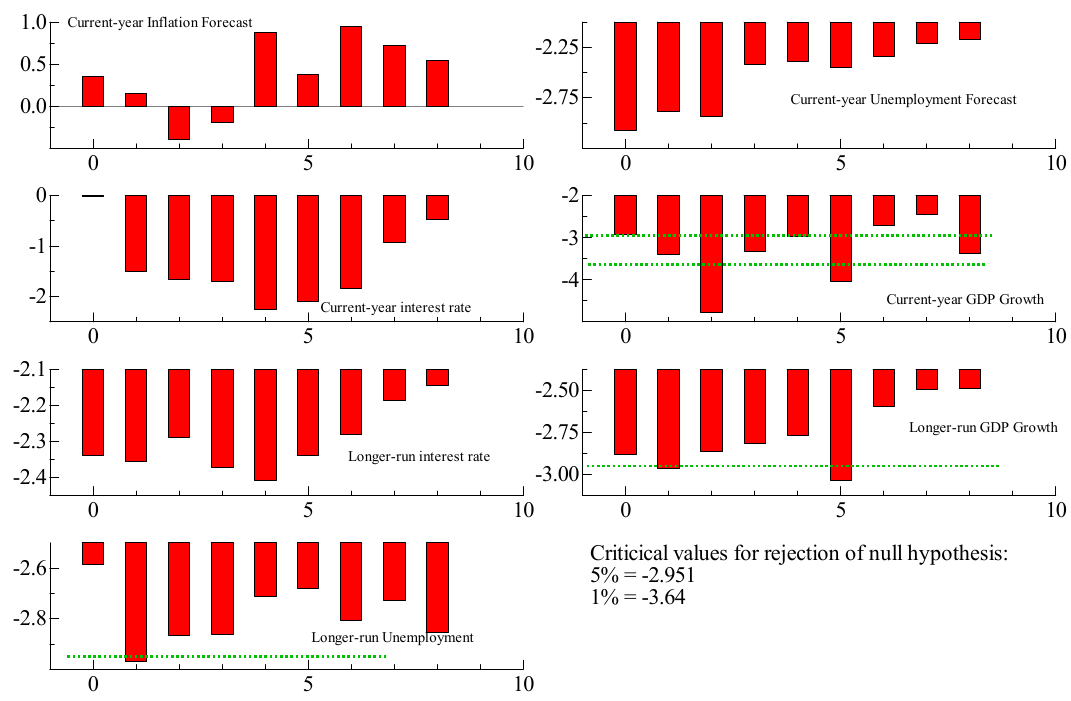
Figure A2. Augmented Dickey–Fuller tests for current-year and longer-run forecasts of the FOMC. Dashed green lines are the critical values for rejecting the null hypothesis.